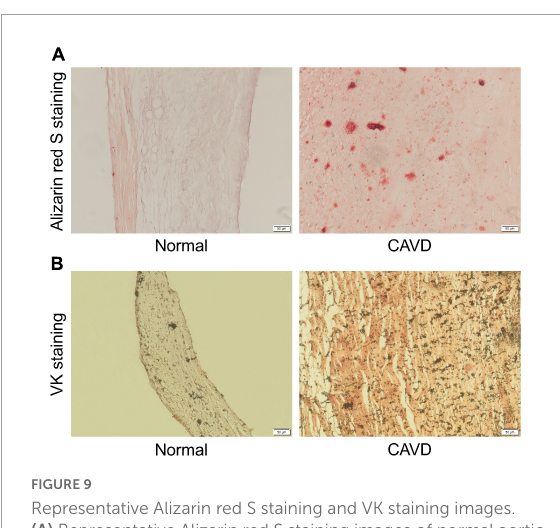
FIGURE9 Representative Alizarin red S staining and VK staining images. (A) Representative Alizarin red S staining images of normal aortic valve tissue and calcified aortic valve tissue. (B) Representative VK staining images of normal aortic valve tissue and calcified aortic valve tissue.